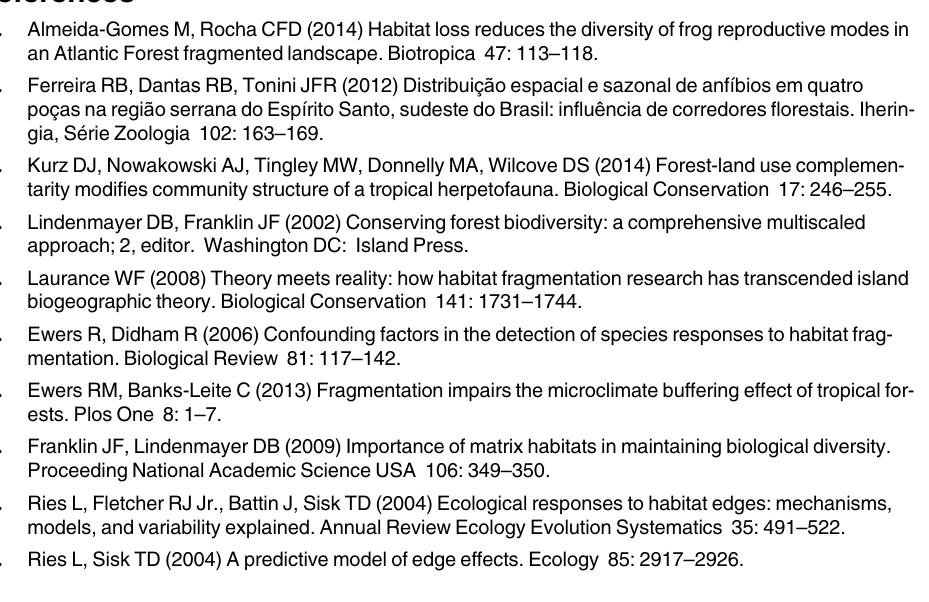
S2 Table. Model comparison of frog richness and abundance. Response variables evaluated in relation to ‘ Breeding guild ’ , ‘ Distance ’ , and ‘ Season ’ , after excluding the three most abundant frog species from the dataset. S3 Table. Model comparison of frog richness and abundance. Response variables evaluated in relation to ‘ Breeding guild ’ , ‘ Matrix type ’ , and ‘ Season ’ for data collected in each of the three distances inside the forest